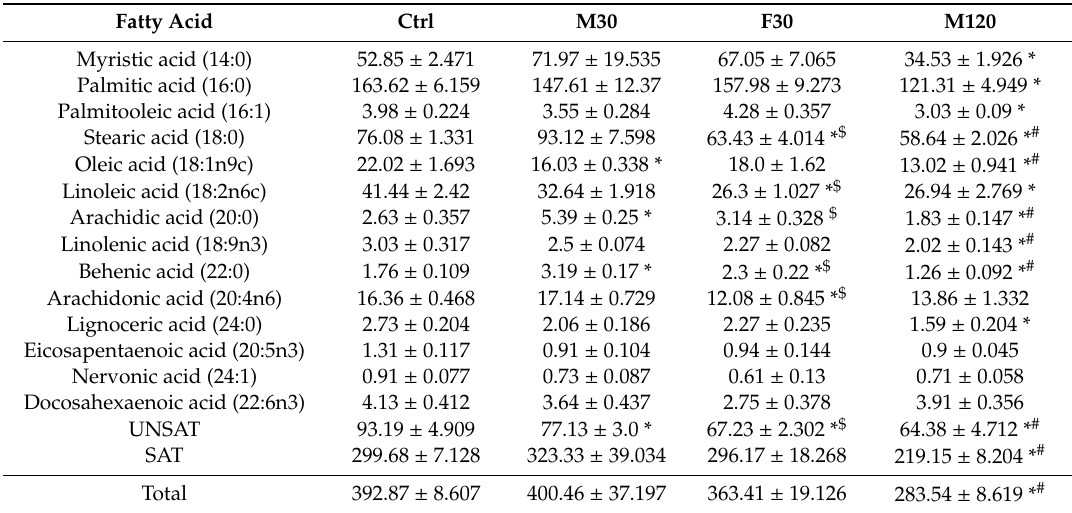
Table A2. The left ventricle DG—fatty acid composition (nmol / g of wet tissue).